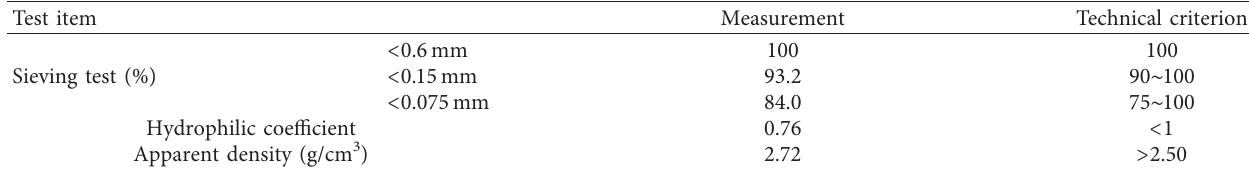
Table 3: Test results of limestone mineral powder performance.